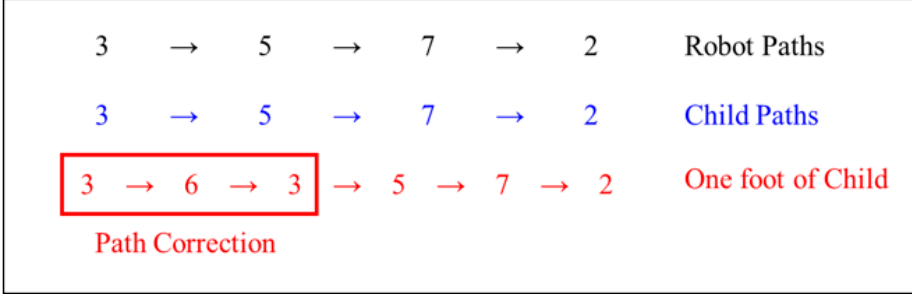
Figure 8. Indicator B4_2 (incorrect path before correct path).